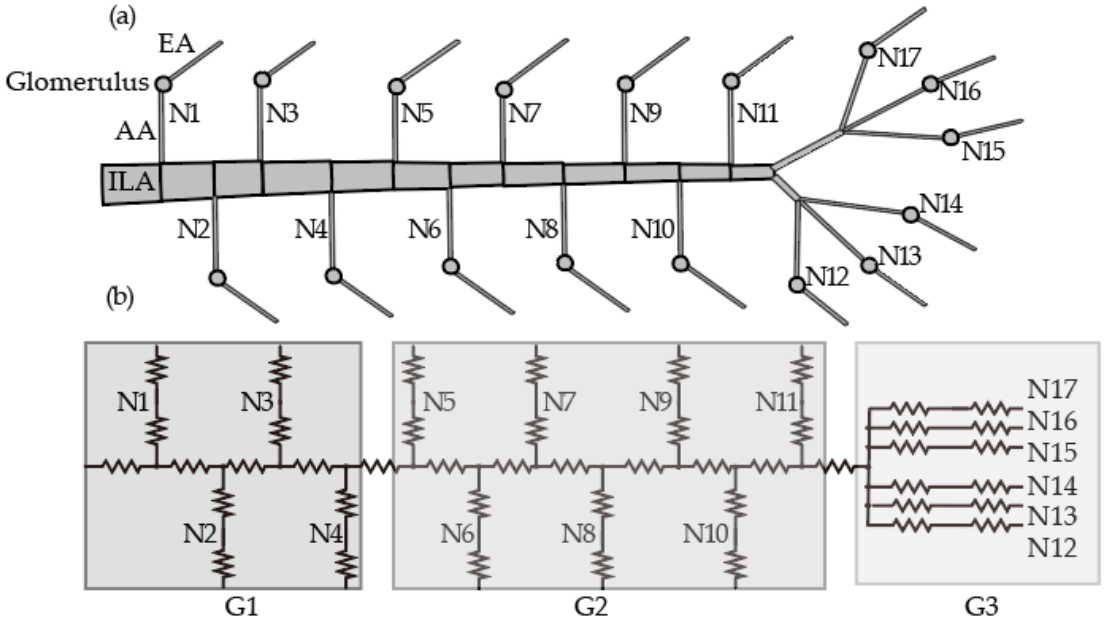
Figure 1. ( a ) The vascular structure and ( b ) the equivalent resistance network of the vascular segment. There are 17 nephron units (N1, N2, …, N17), which are classified into three groups (G1, G2 and G3) in the order of branching.